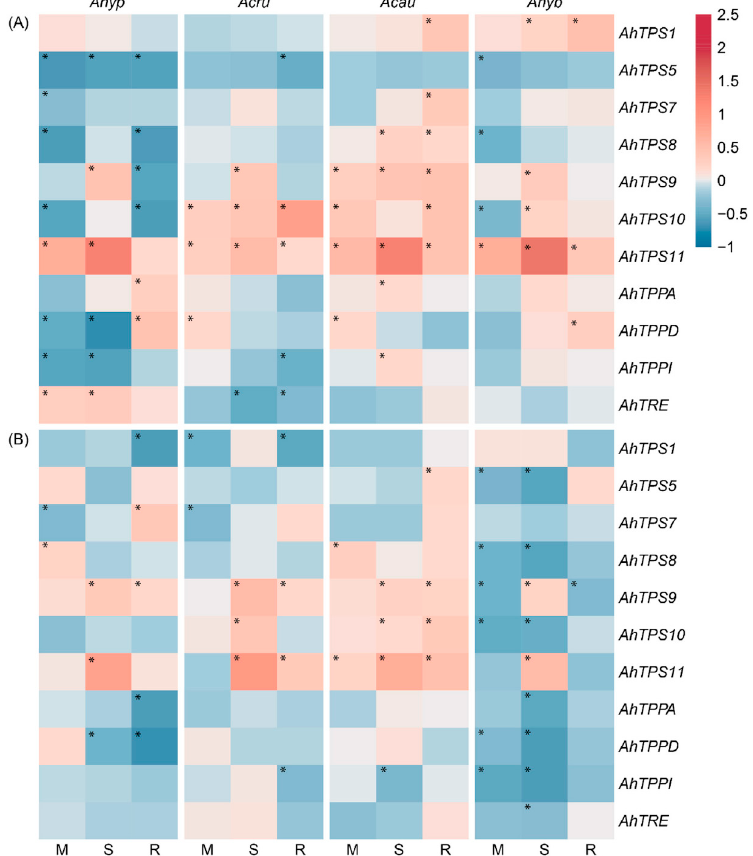
Figure 12. Relative expression of genes involved in trehalose synthesis and degradation in ( A ) leaves and ( B ) roots of Amaranthus hypochondriacus (Ahypo), A. cruentus (Acru), A. caudatus (Acau), and A. hybridus (Ahyb) plants subjected to moderate (M) or severe (S) water deficit stress, or allowed to recover from S, 1 day after normal watering was restored (R). Induced (normalized expression values ≥ 1.5; in red) and repressed (normalized expression values ≤ 0.5; in blue) gene expression values, represented in a log 10 basis, are highlighted with an asterisk at the upper left side of the cells. They were calculated according to the comparative cycle threshold method [28] using the AhACT7 , AhEF1a and Ah β Tub5 amaranth genes for data normalization. 2.5. WDS Tolerance and Changes in SnRK1 and TOR Activity in Leaves and Roots The rationale behind SnRK1 and TOR activity assays was to determine the effect of reduced energy supplies, typically caused by stress conditions, on the activity of these two master regulators of metabolism. While SnRK1 activates catabolism and represses energy-consuming anabolic processes in response to declining energy availability triggered by stress, TOR is known to promote growth via the integration of energy surplus with increased cell proliferation and development, protein synthesis, transcription, and metabolism [33,34]. In the amaranth species analyzed, SnRK1 activity was higher in roots. In A. hypochondriacus , the already high basal leaf and root SnRK1